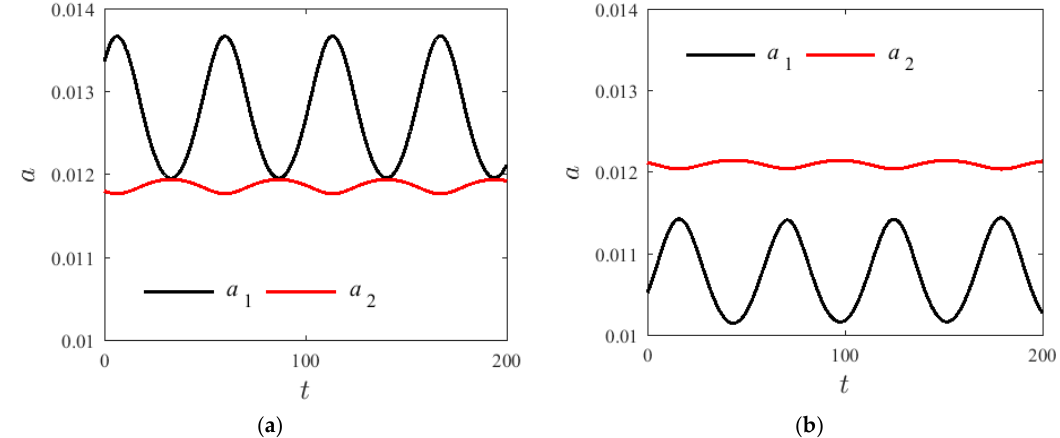
Figure 4. Variation modes for different initial conditions γ ( a 10 = a 20 = 0.012); ( a ) γ 0 = 0, ( b ) γ 0 = 2 π .